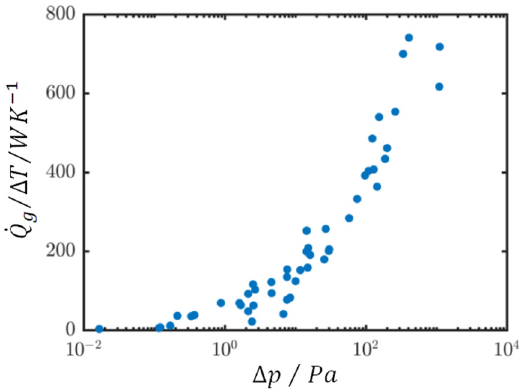
Figure 11. Comparison of the heat exchanger transmission capacity in terms of pressure drop for a variation of heat exchanger geometric parameters.